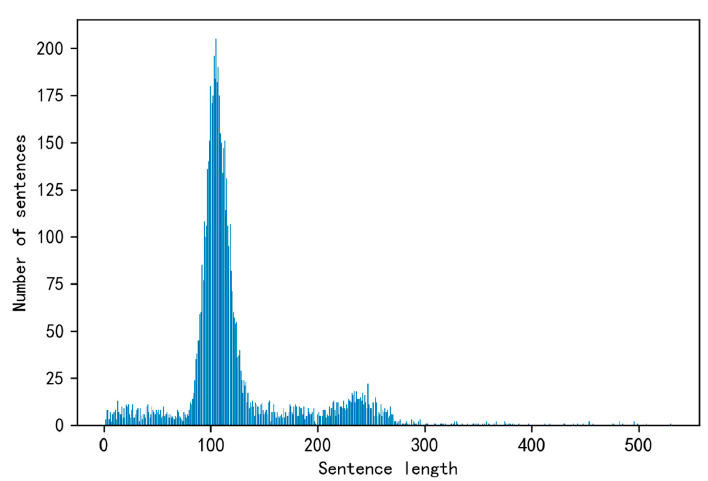
Figure 3. Length of the comment text in the Harry Potter Wizarding World Theme Park in Orlando, USA.